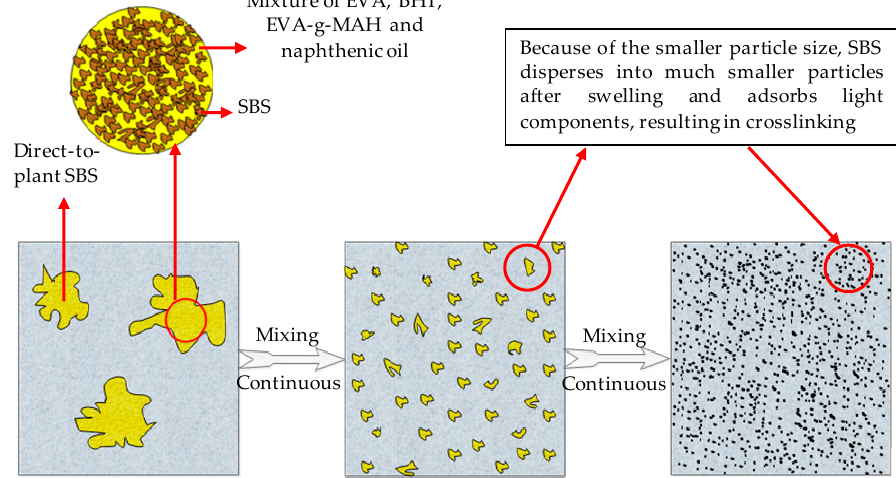
Figure 2. Diagrammatic sketch of the dispersion and swelling process of direct-to-plant SBS modifier in bitumen.